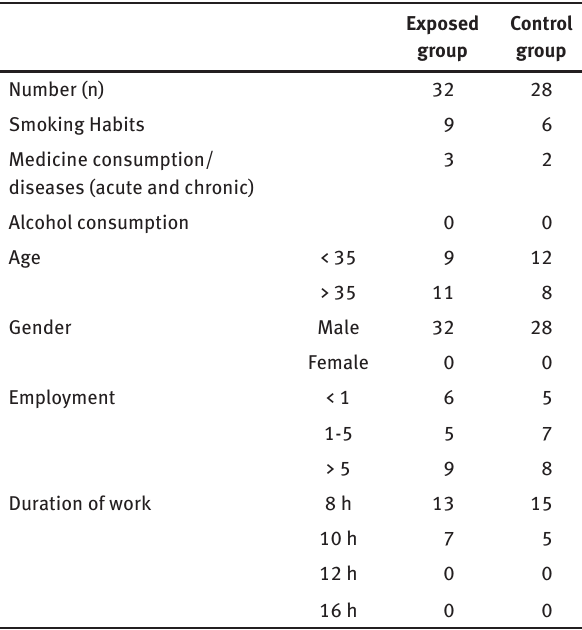
Table 1: Demography and other characteristic of donors from both